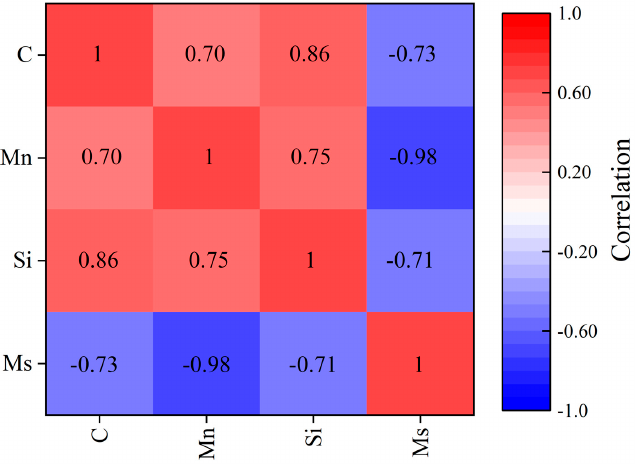
Figure 4. The Pearson-correlation-analysis results for composition .